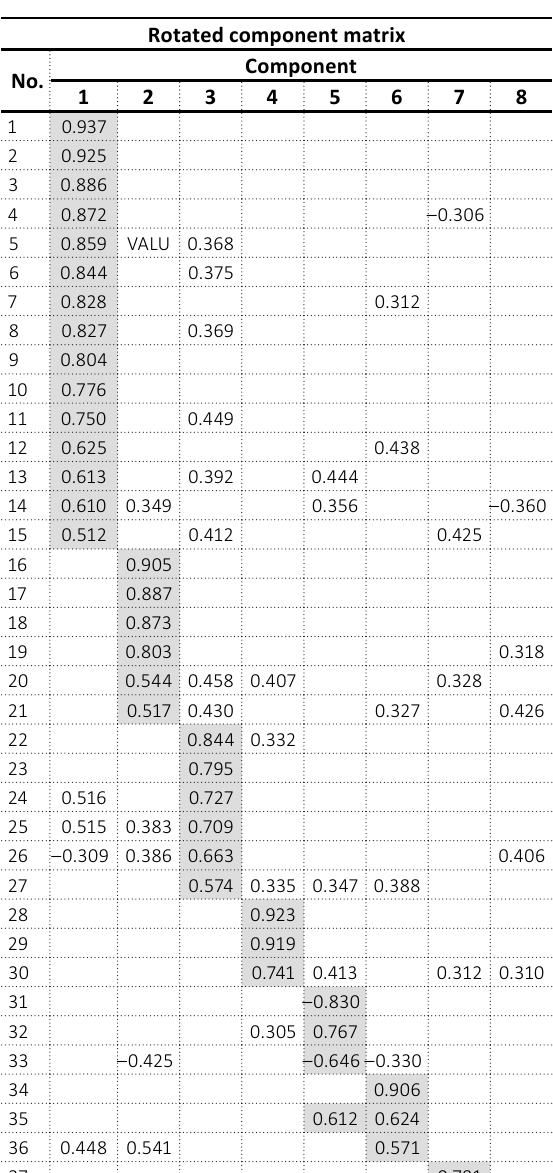
Table 2. Rotated component matrix using the VARIMAX method. Cut level: